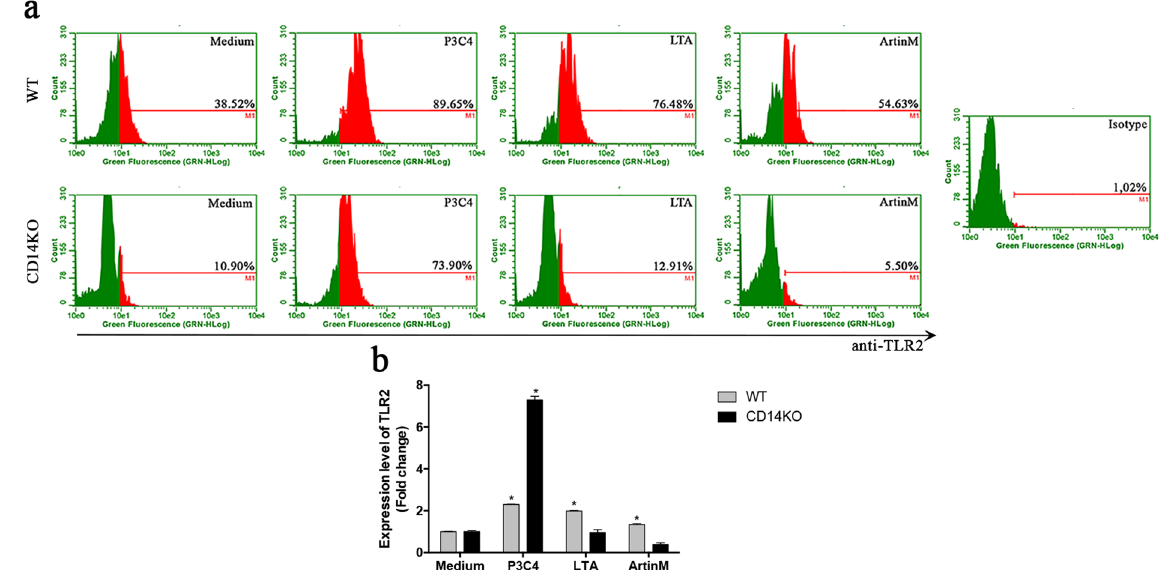
Figure 5. Expression of TLR2 in ArtinM-stimulated macrophages decreases in the absence of CD14. Macrophages (1 × 10 6 /mL) from the WT and CD14 KO mice were stimulated with ArtinM (2.5 µ g/mL), P3C4 (1 µ g/mL), LTA (1 µ g/mL), or medium for 48 h. The macrophages were incubated with anti-TLR2 antibody (15 µ g/mL), and the fluorescence was measured by flow cytometry. ( a , histogram) The percentage of fluorescent cells stained for TLR2 was determined for each condition, and ( b , bars) was calculated the fold change of the TLR2 expression under stimuli compared to the medium. The data are shown as means ± SEM of